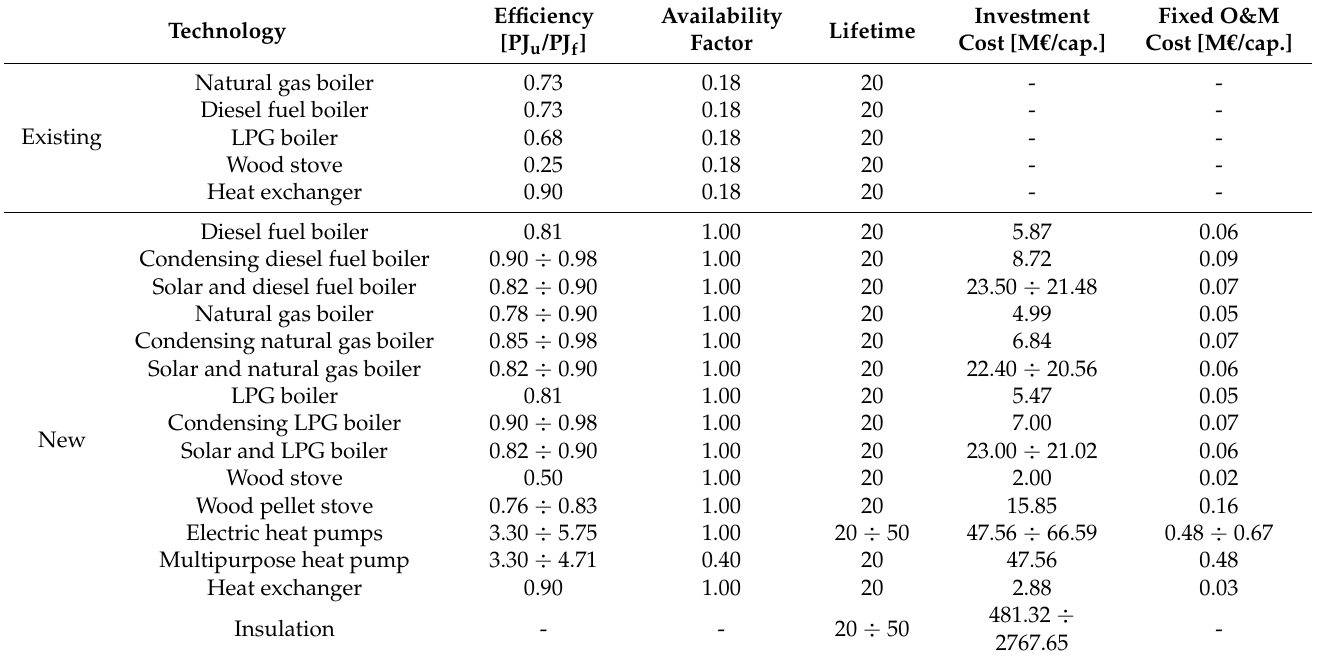
Table A4. Techno-economic characterization for residential space heating technologies